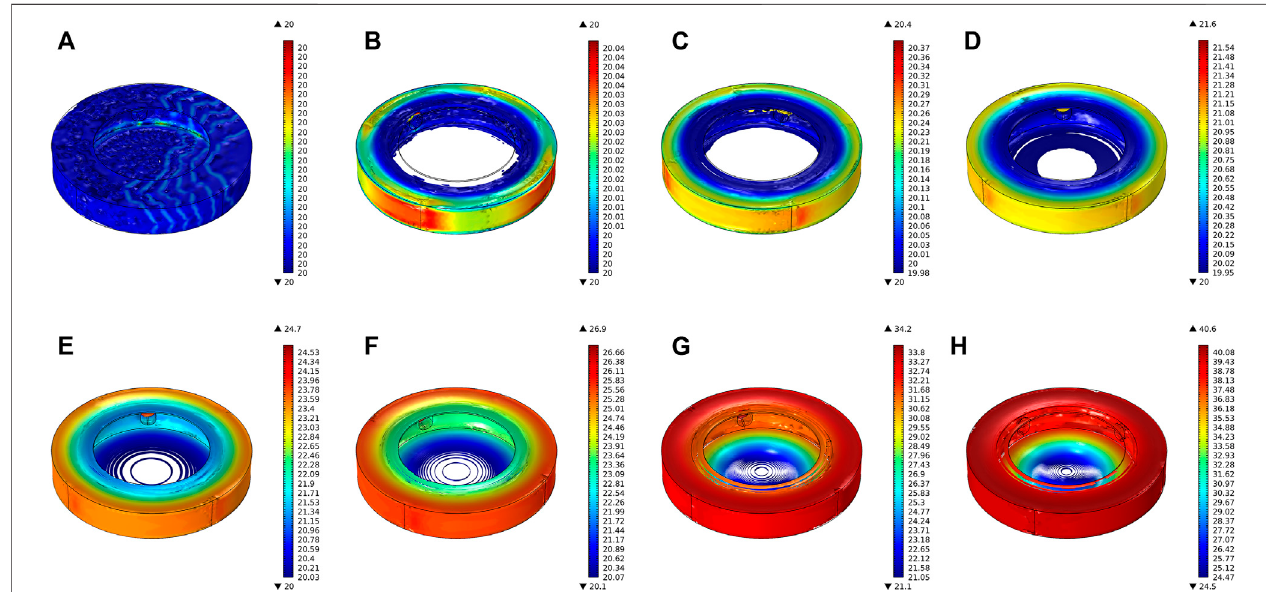
FIGURE 13| Transient temperature distribution of MRG torsional vibration damper for each momentof working condition Ⅲ : (A) t= 0 s, (B) t = 0.4 s, (C) t = 0.8 s, (D) t = 1.5 s, (E) t = 3 s, (F) t = 4 s, (G) t = 7 s, and (H) t = 10 s.